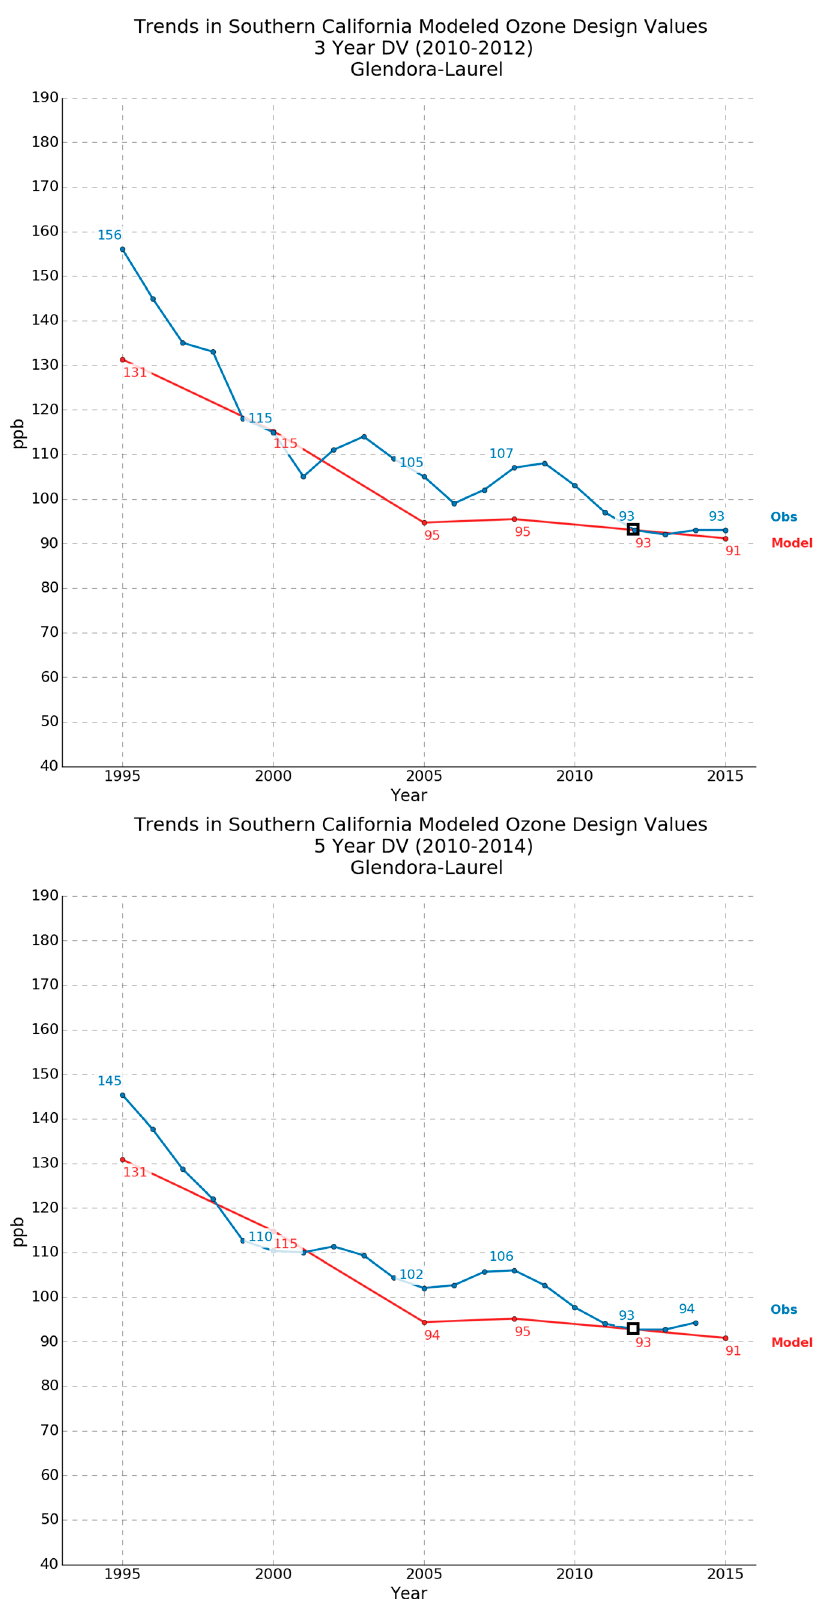
Figure 8. Modeled and observed trends in 3-year ( top ) and 5-year ( bottom ) design values at the Glendora monitor from 1995 to 2015 using the 2016 AQMP modeling database. The anchor (baseline) year for the design value calculations is 2012 (marked by the square symbol in the figures).